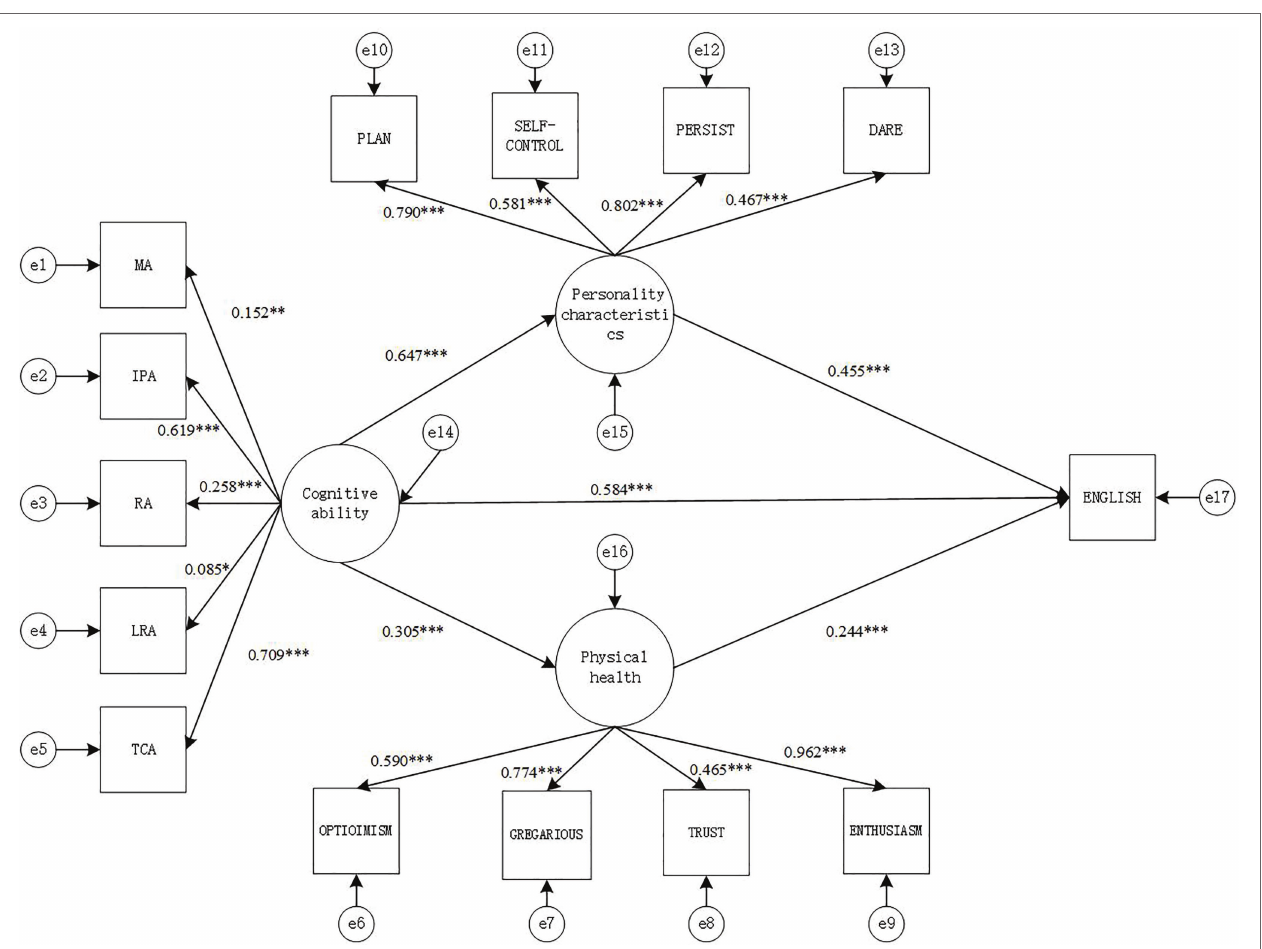
FIGURE 4 | Structural equation intermediary relationship model diagram (model 4). MA, memory ability; IPA, information processing ability; RA, representation ability; LRA, logical reasoning ability; TCA, thinking conversion ability; TS, academic performance. * p < 0.05, ** p < 0.01, and *** p < 0.001.